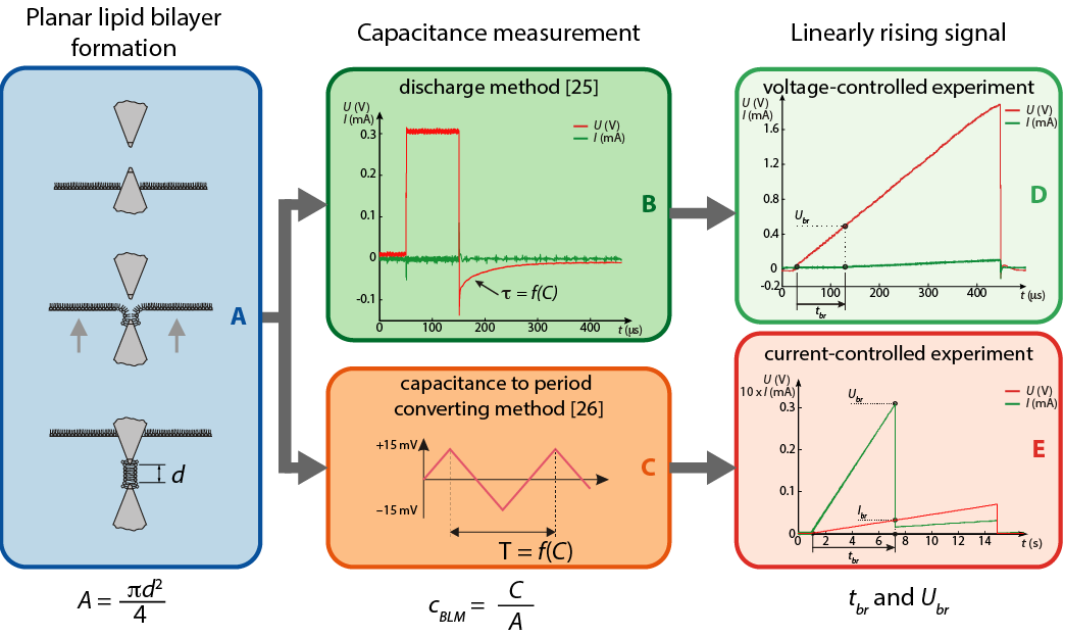
Figure 1. The measurement protocol consisted of formation of the planar lipid bilayer ( A ), capacitance measurement ( B or C ), and measurement of the breakdown voltage U br of the planar lipid bilayer ( D or E